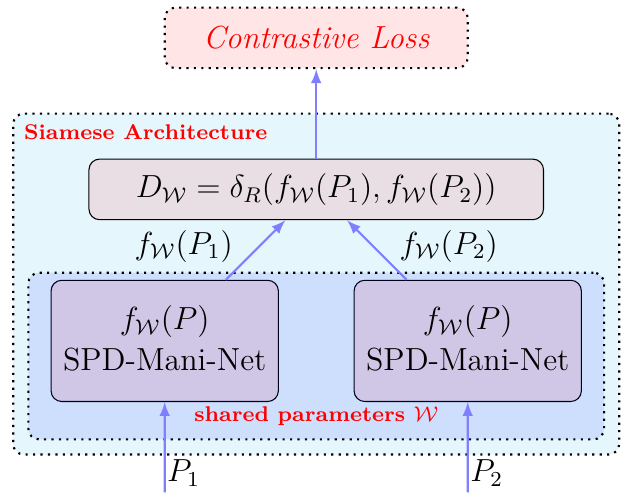
Figure 3. Conceptual illustration of Siamese architecture for metric